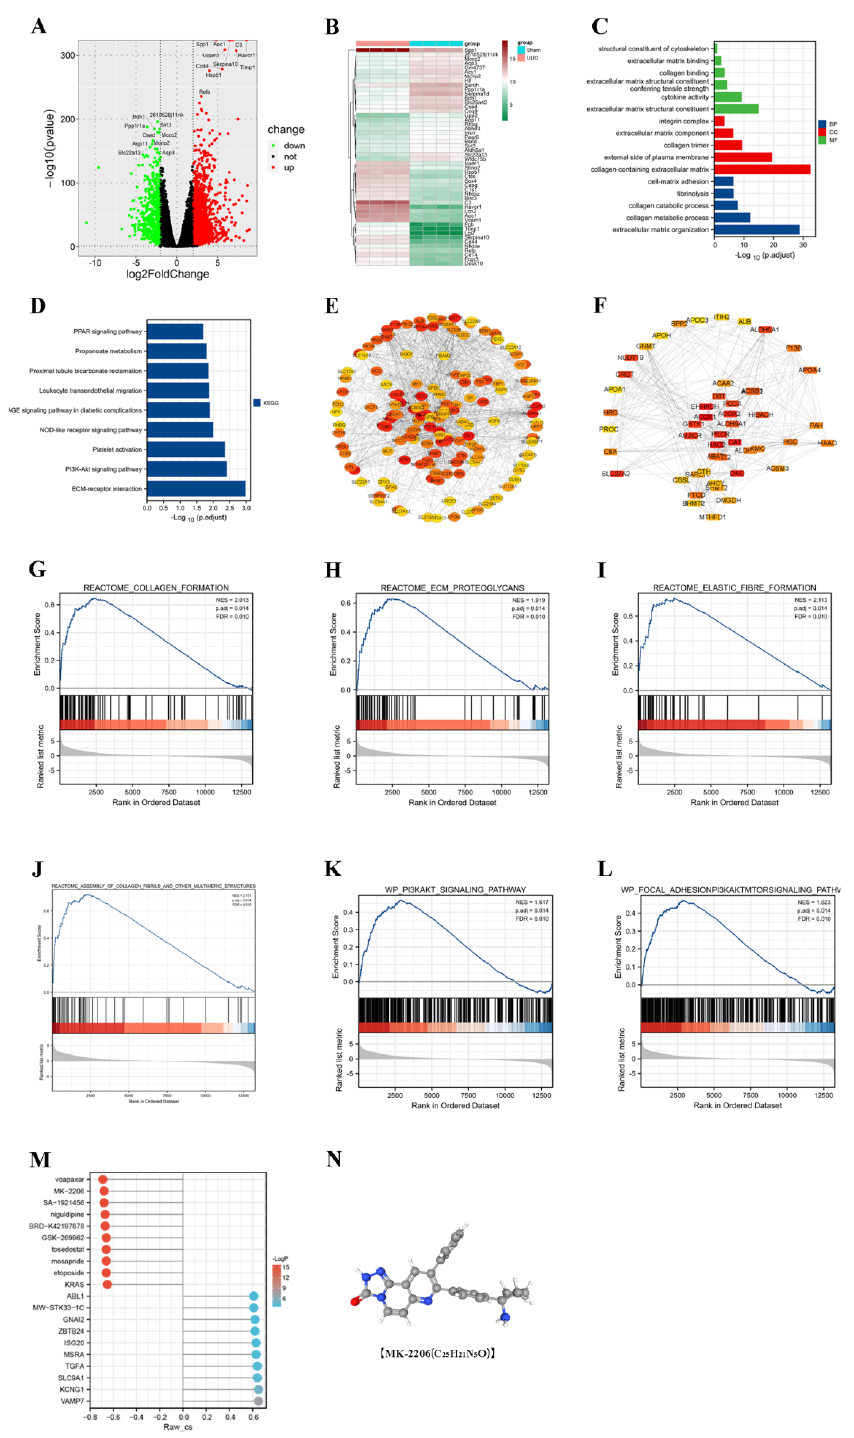
Figure 2. Transcriptome sequencing results analyzed by bioinformatics. ( A , B ) Visualization of differ- entially expressed genes between sham and UUO groups using volcano and heat maps. ( C , D ) Gene ontology (GO) and Kyoto Encyclopedia of Genes and Genomes (KEGG) enrichment analysis of differentially expressed genes. ( E ) Construction of protein-protein interaction (PPI) networks to identify and visualize key differentially expressed genes. ( F ) Top 150 selected key differential genes. ( G – L ) Exploration of potential pathways using Gene Set Enrichment Analysis (GSEA). ( M ) Prediction of potential anti-fibrotic drugs by the connectivity map (CMap). ( N ) Chemical structure of